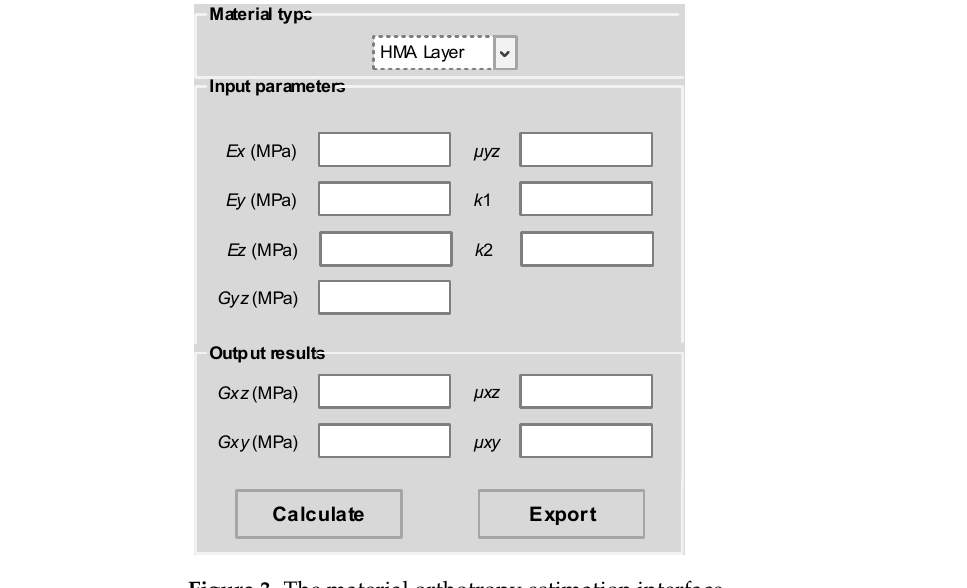
Figure 3. The material orthotropy estimation interface. Table 2. The design of the material property